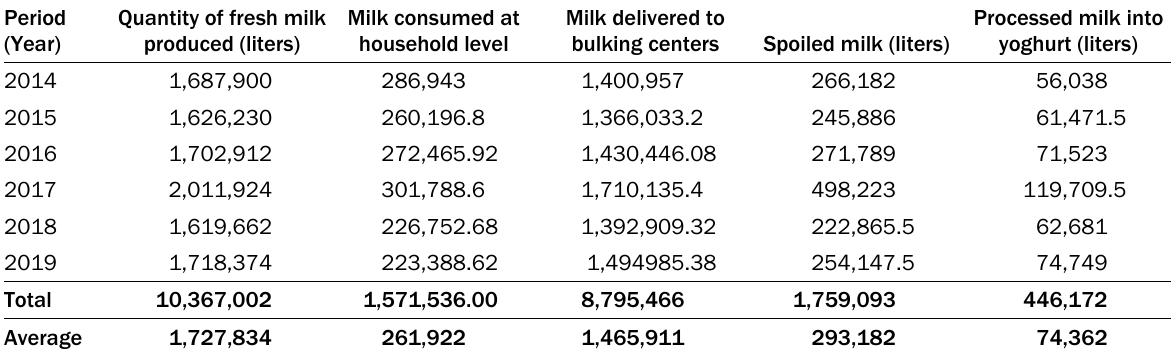
Table 2. Quantities of Camel Milk Produced in the County During 2014 –